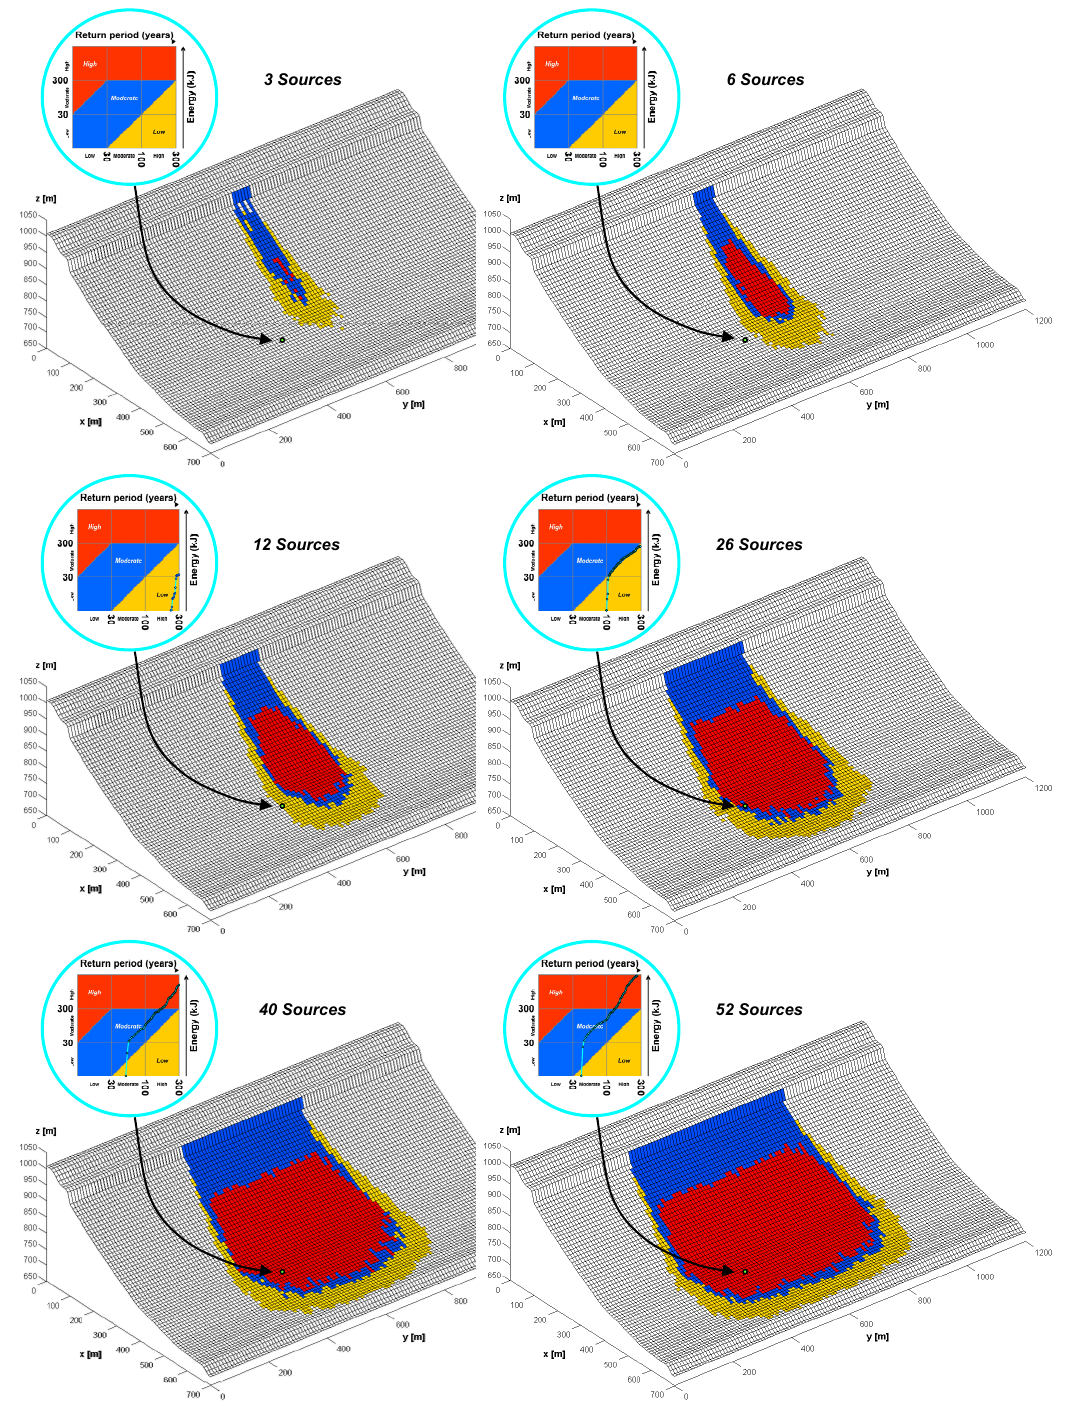
Figure 8. Hazard zoning for increasing number of rock fall sources along a linear cli ff , for a failure frequency of λ f, 2 D = 0.0038 (years − 1 · m − 2 ) (i.e., λ f,cell = 0.38 years − 1 ). The hazard curve superimposed to the intensity-frequency diagram helps in understanding how a point located relatively far from the source area can be a ff ected by a hazard whose degree increases according to the combined e ff ect of an increasing number of sources of